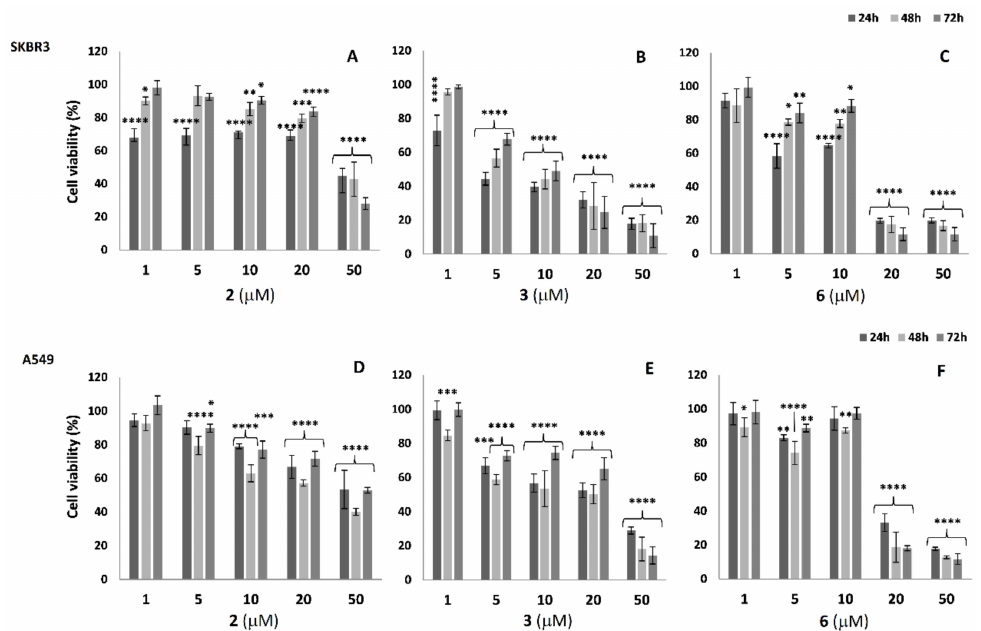
Figure 4. Cell viability analysis in SKBR3 (top panels) and A549 (bottom panels) cells treated with AE ( 2 ), the glutaryl derivative ( 3 ), and the peptide-conjugate AE-CPP-LTV ( 6 ) at 24, 48 and 72 h. SKBR3 treated with AE ( A ); SKBR3 cells treated with glutaryl derivative ( B ), SKBR3 cells treated with the peptide conjugate ( C ); A549 cells treated with AE ( D ), A549 cells treated with glutaryl derivative ( E ) and A549 cells treated with peptide conjugate ( F ). Data were expressed as cell metabolic activity, calculated as absorbance value of cells treated with different compounds/absorbance value of control cells * 100%. Data are represented as mean ± standard deviation. Two-way ANOVA with Dunnett’s multiple comparisons test was performed respect to controls. Asterisks represent significant results (* p < 0.1, ** p < 0.01, *** p < 0.001, ***** p <